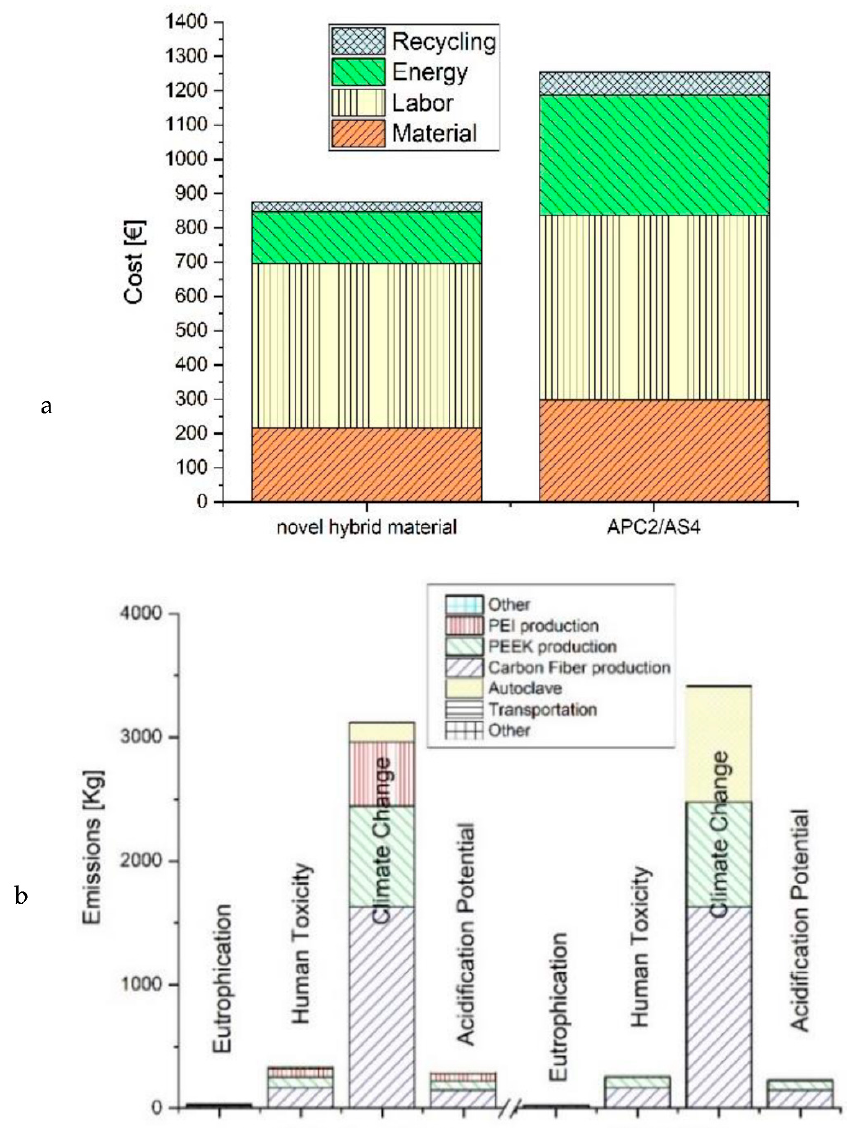
Figure 9. Allocated cost ( a ) and main environmental impact factors for both materials considered ( b ).